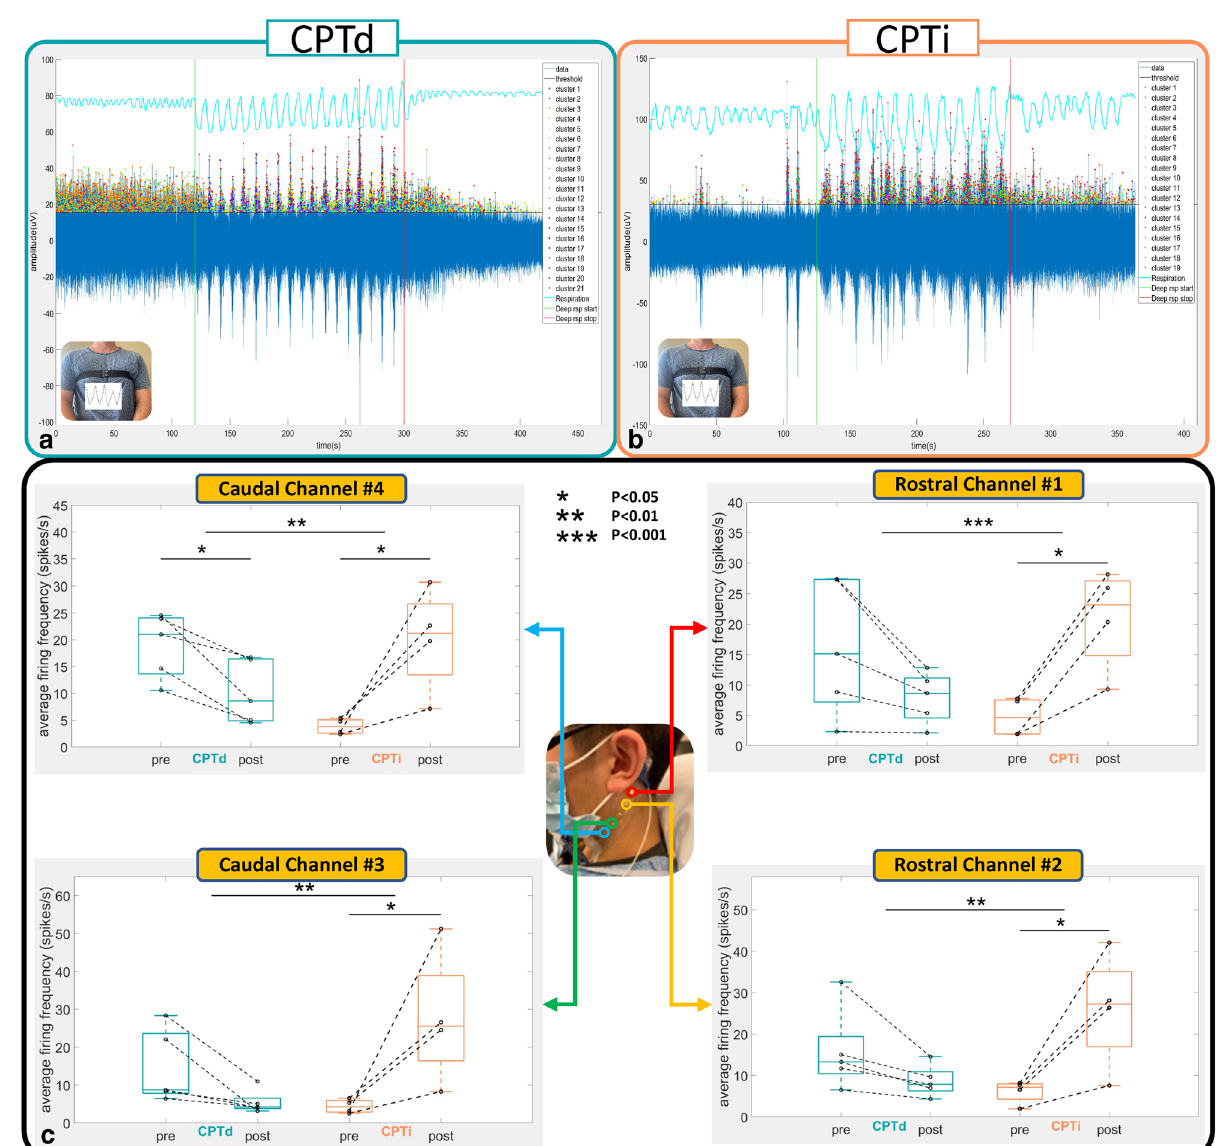
Figure 5. Neuronal firing comparison between CPTd and CPTi groups during the respiratory challenge. ( a , b ) The green vertical line indicates initiation of the respiratory challenge, while the red vertical line indicates cessation of the respiratory challenge. The blue line captures the amplitude of the recorded electrode data for electrode positioned over the upper nodose ganglion (Channel #1). The peak of each detected spike (exceeding the threshold value) is indicated by spike coloraction in the positive y-axis, representing the different clusters. The respiration belt voltage is plotted in cyan using the right y-axis. ( a ) Exemplar CPTd CEN neural firing change during deep respiratory challenge. ( b ) Exemplar CPTi CEN neural firing change during deep respiratory challenge. ( c ) Average firing frequencies comparison between pre- and post-challenges for CPTd and CPTi groups across four channels. All channels in the CPTi group have significant neuronal activity increase after deep respiratory challenge (p < 0.05), whereas only Channel #4 in the CPTd group has significant decreased activity. We observed significant between group (CPTd vs CPTi) differences (p < 0.01) in neuronal firing change across all